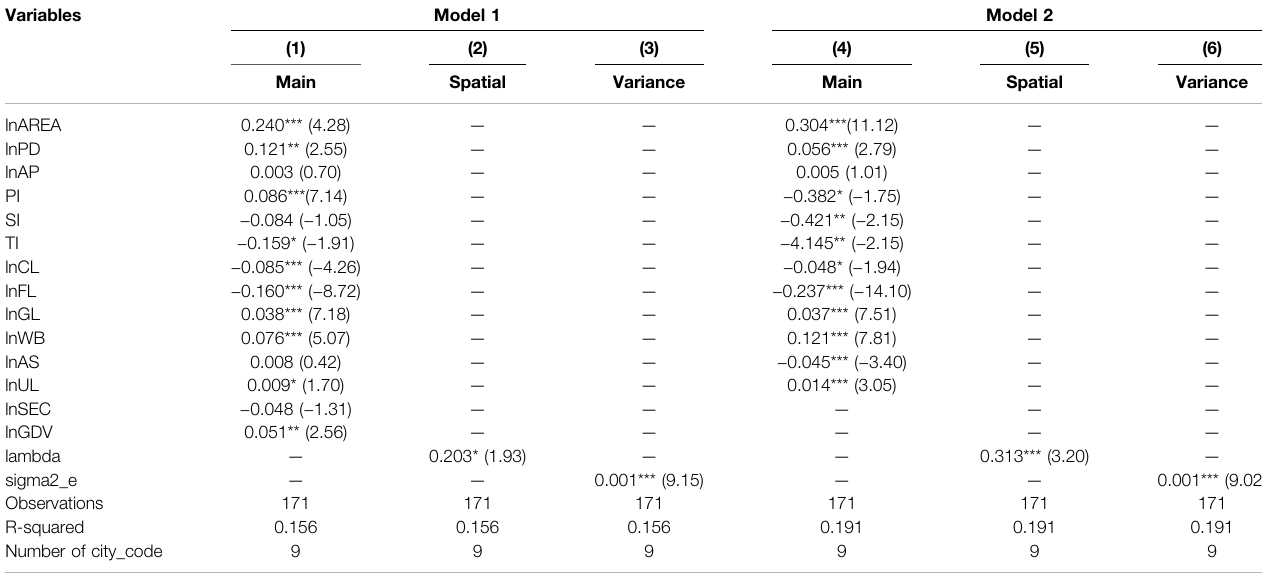
TABLE 3 | The estimation results of the spatial error model.